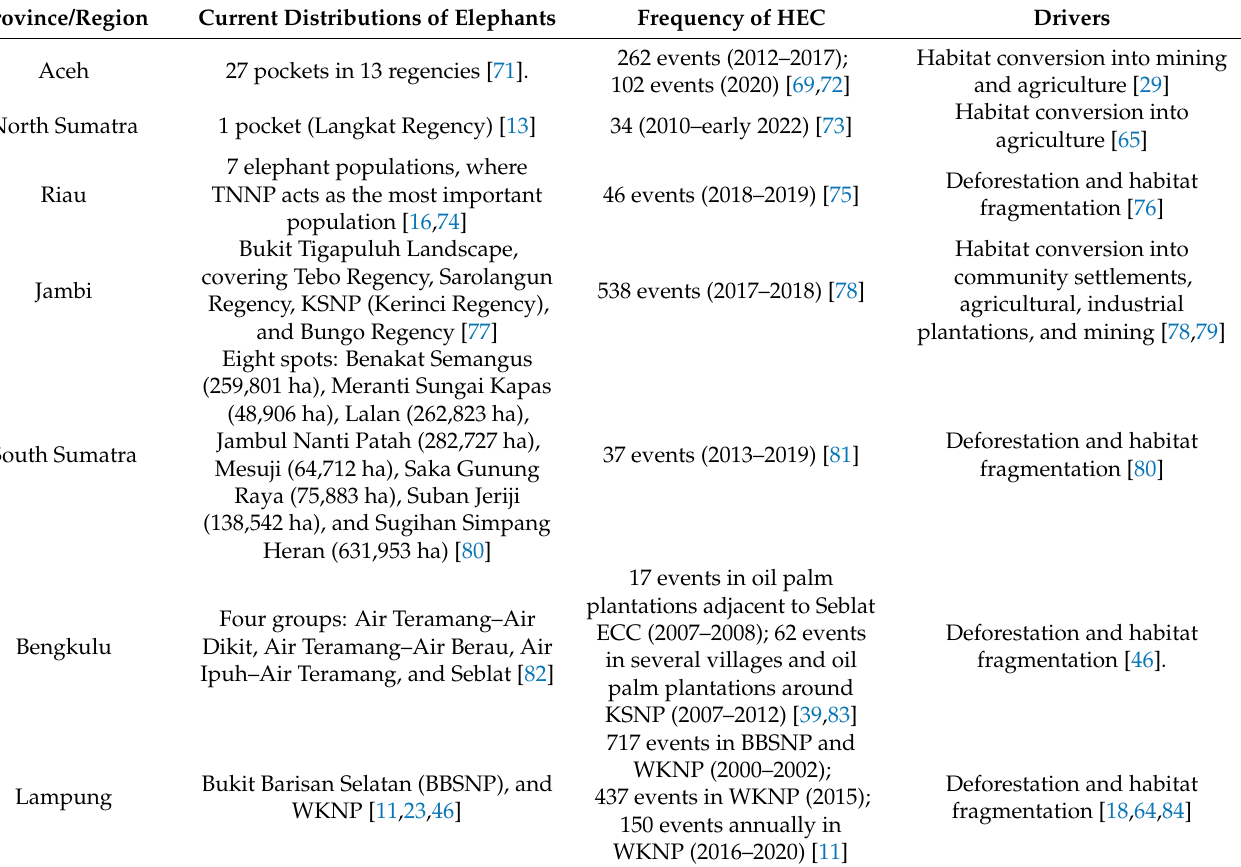
Table 3. HEC across Sumatra